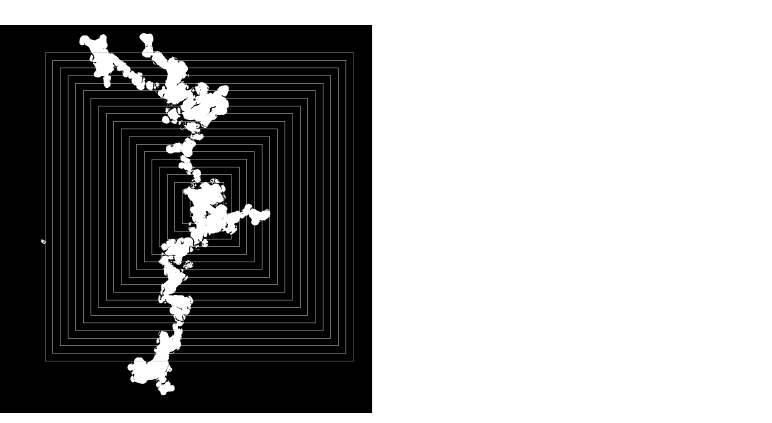
Figure 2. A TEM image processed in ImageJ after the Nested Square Method was carried out.